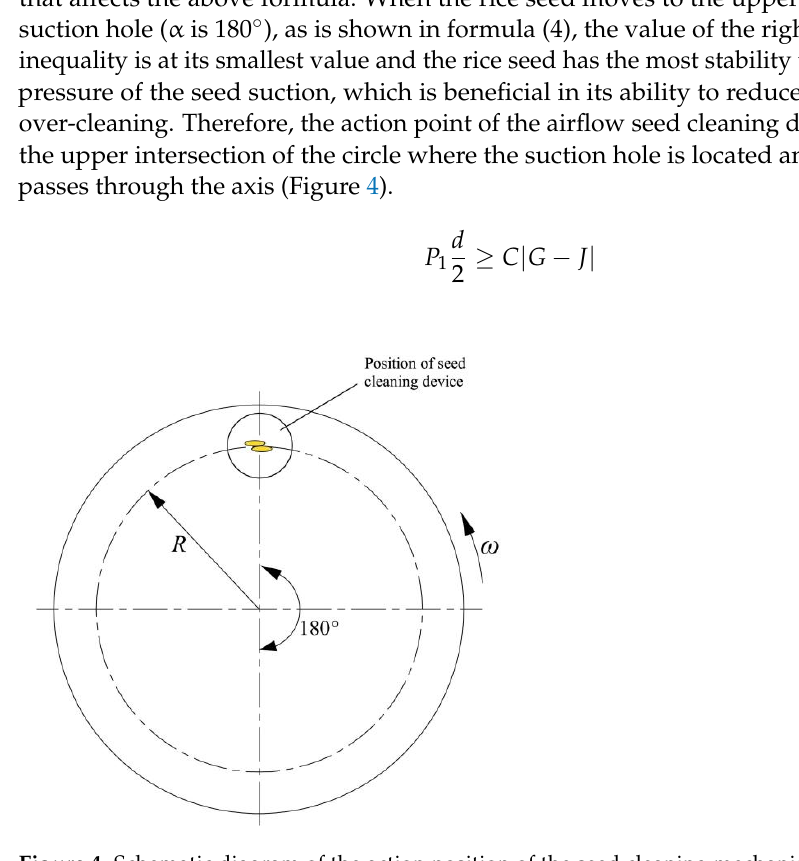
Figure 4. Schematic diagram of the action position of the seed cleaning mechanism: R is the radius of the circle where the suction hole is located mm; ω is the rotation speed of the seeding plate rad/s.